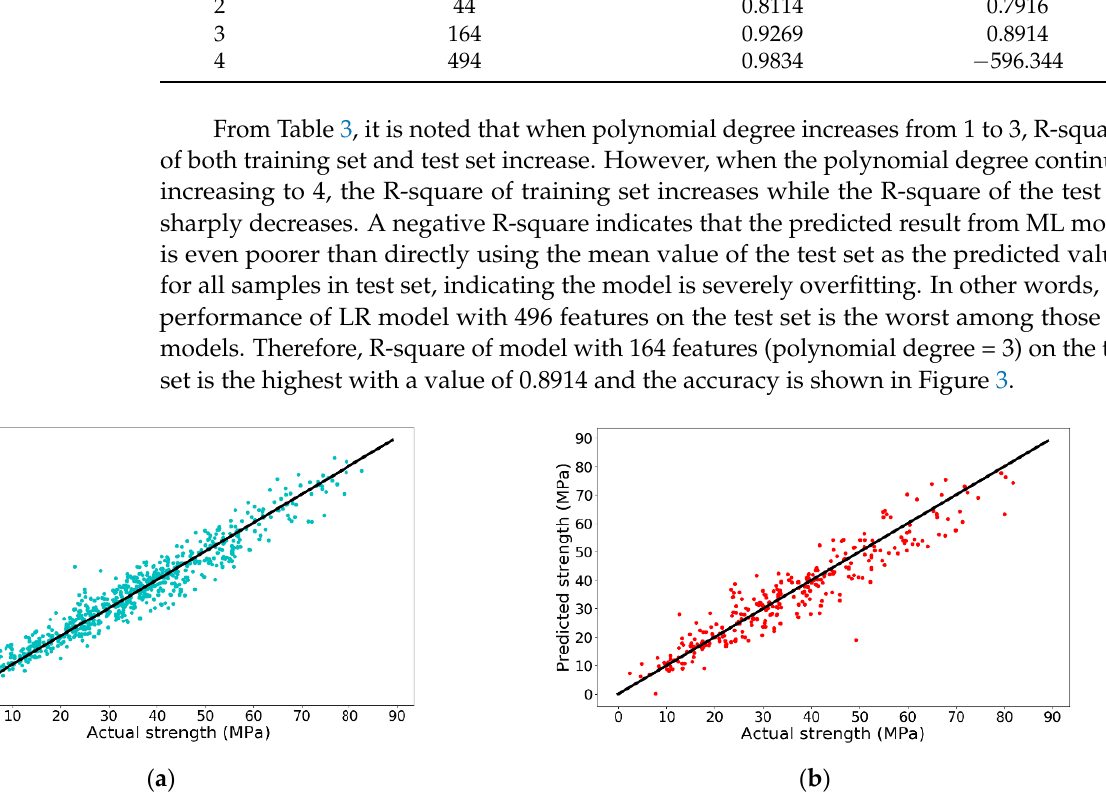
( b ) Figure 4. R-square of SVR under different hyperparameters: ( a ) different C and ( b ) different γ .